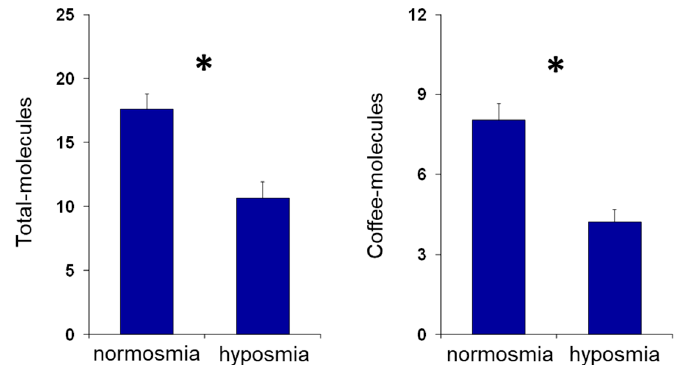
Figure 1. Mean ( ± SEM) values on the number of total- and coffee-molecules smelled during the GC-O experiments by each subject, according to their TDI olfactory status. Asterisk indicates significant differences between individuals with normosmia or hyposmia ( p < 0.0005; Fisher’s LSD test subsequent to one-way ANOVA).